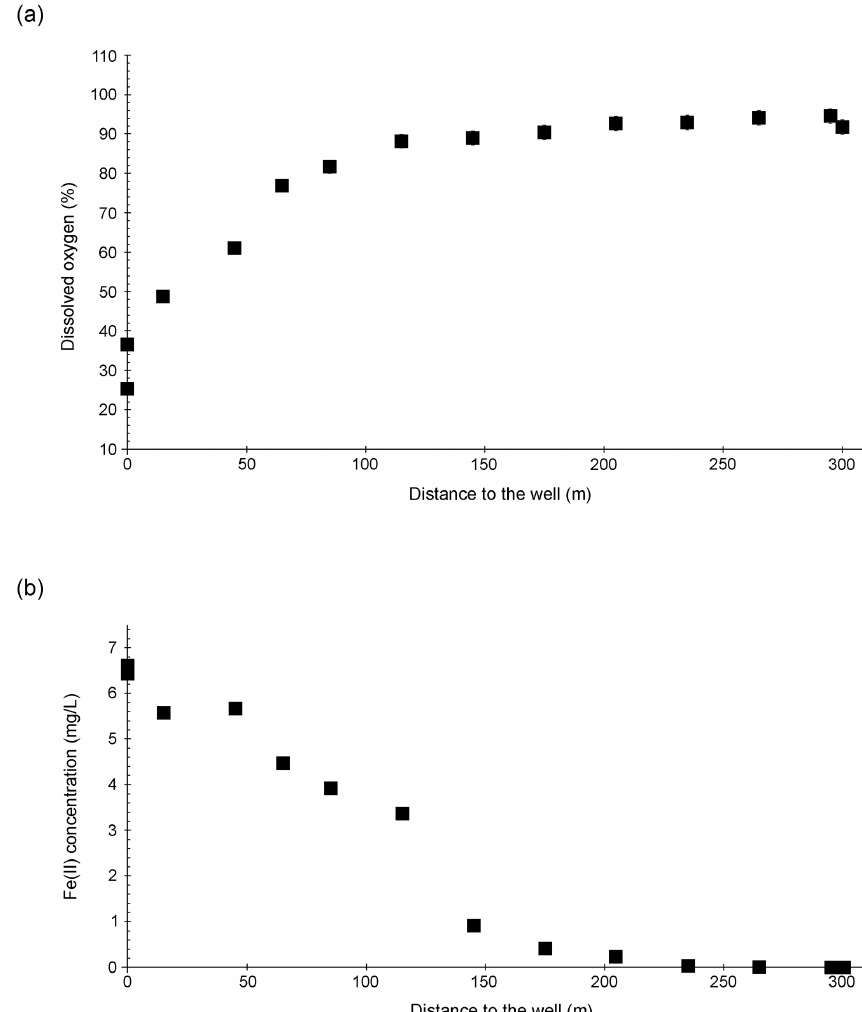
Figure 4. (a) Dissolved oxygen (%) and (b) Fe(II) concentrations over the course of the Espan System in an example graph for the cold season in February. The error for DO was 2%, and for Fe(II) it was 0.06mgL − 1 . Errors are within the symbol